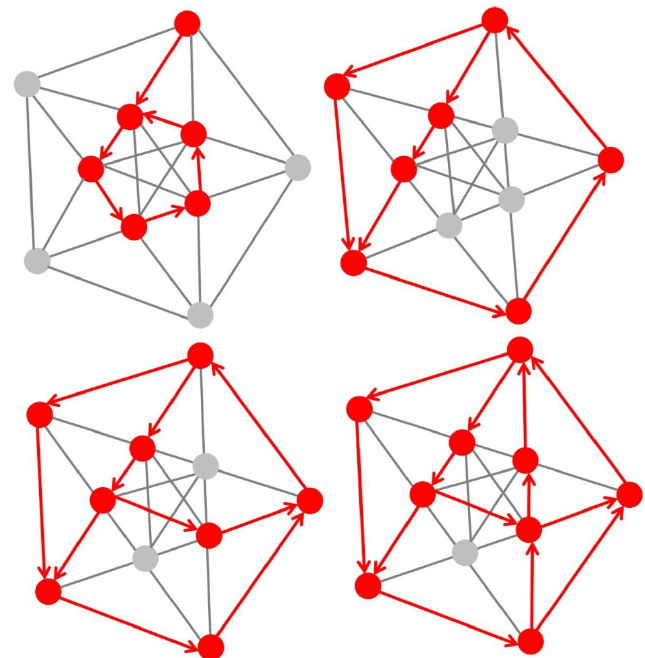
Figure 2. Schematic illustration of self-organizing formation of dedicated resonant circuitry in a fixed-size neural network of 10 neurons only. An exponential number of functional states are possible therein, allowing even a small-size network to develop new, dynamic functionalities without the need for adding further structural complexity. Resonant neurons (highlighted in red color) are primed throughout their functional development to preferentially process input which carries statistically “strong” signals, as explained previously in [79]. When activated, resonant neurons send signals along all delay paths originating from them, and all those receiving a signal coinciding with the next input signal remain activated. The formation of resonant circuitry is activity-dependent; long-term potentiated connections between resonant neurons may become progressively depressed, as in the model of self-reinforcing (Hebbian) synaptic learning, when their function is no longer activated.